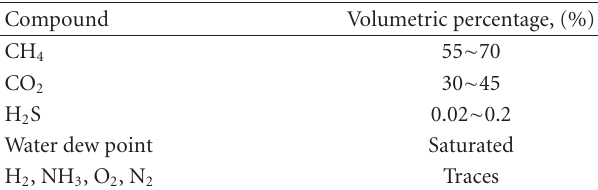
Figure 2: Biogas lower heating value on mass and volume basis. Table 1: Typical composition of